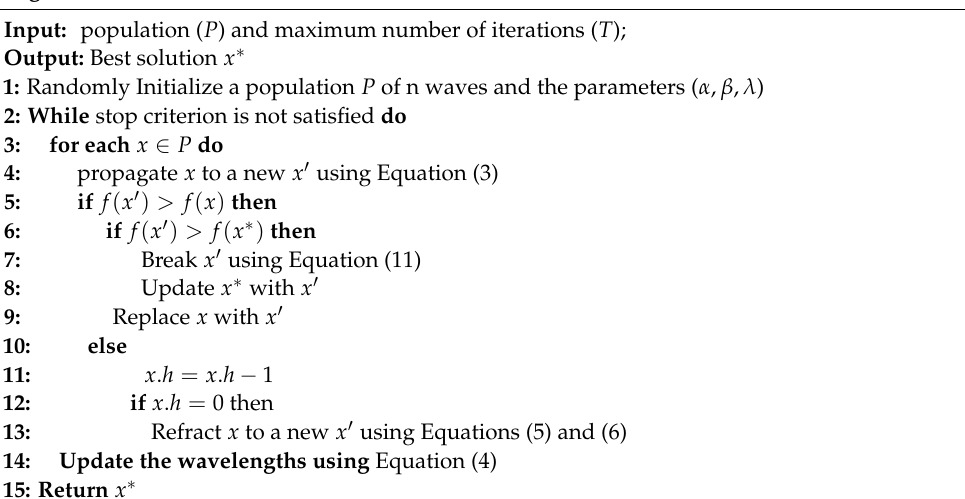
Algorithm 1: Pseudo-Code of LWWO